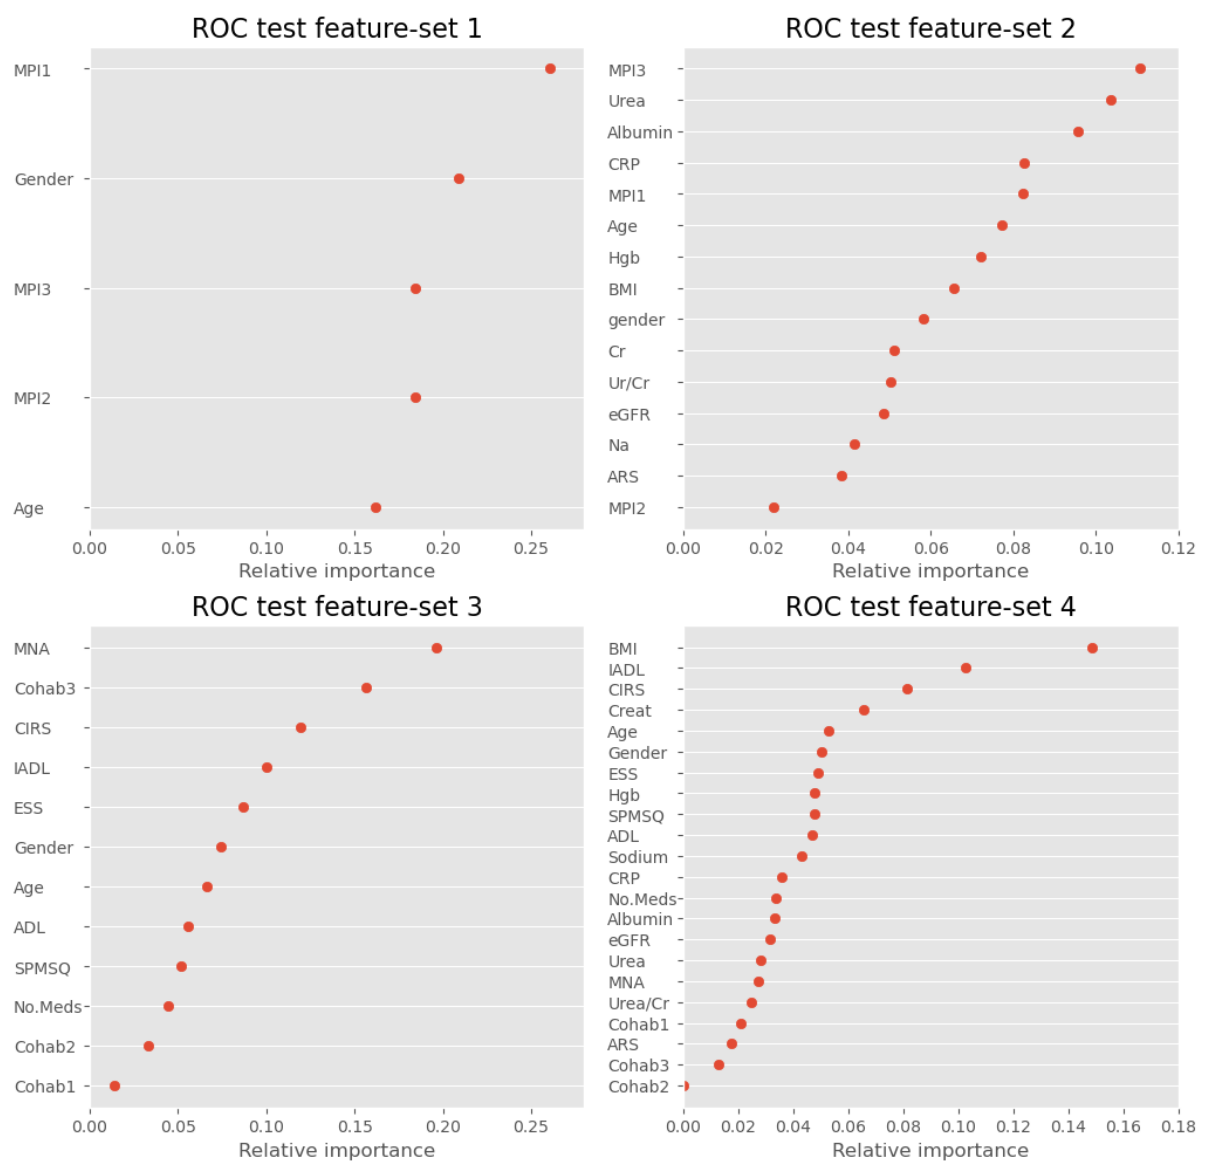
Figure 3. Feature importance plot for the eXtreme gradient boosting algorithm using test data with feature sets 1 to 4. ADL: activities of daily living; ARS: anticholinergic risk score; CIRS: Cumulative Illness Rating Scale; Cohab1: living alone; Cohab2: living with family or friends; Cohab3: living in an institute; Creat: creatinine; CRP: C-reactive protein; eGFR: estimated glomerular filtration rate; ESS: Exton Smith Scale; Hgb: serum hemoglobin; IADL: instrumental activities of daily living; MNA: Mini Nutritional Assessment; MPI: Multidimensional Prognostic Index; MNA: Mini